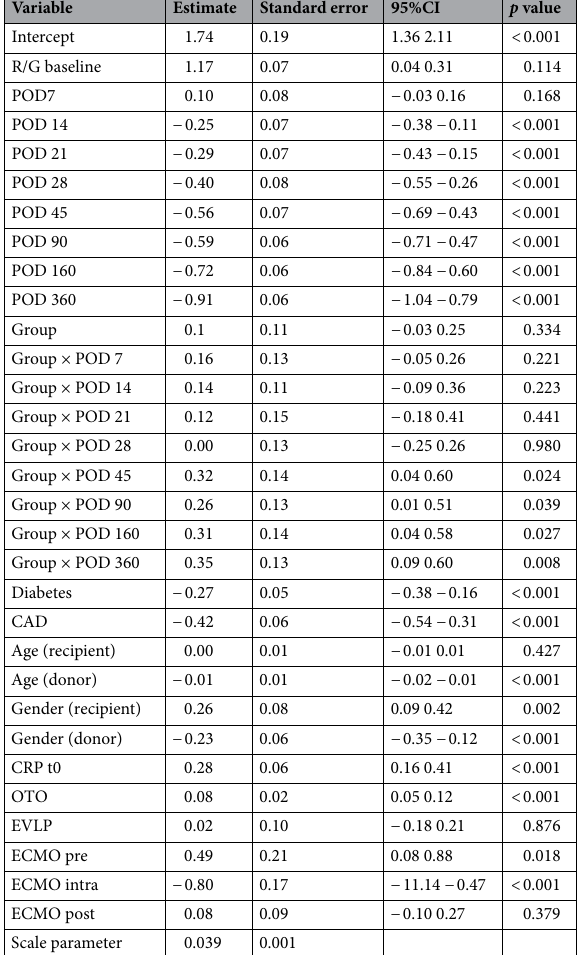
Table 3. Estimated GEE regression coefficients and relative 95% confidence interval based on analysis of response profiles of the R/G ratio level data at baseline, POD7, POD14, POD21, POD28, POD45, 3 months, 6 months and 1 year after LuTx. CAD coronary artery disease, CI confidence interval, CRP C reactive protein, ECMO extracorporeal membrane oxygenation, EVLP ex-vivo lung perfusion, GEE generalized estimating equations, LuTx lung transplantation, OTO Oto score, POD post-operative day, R/G red/green